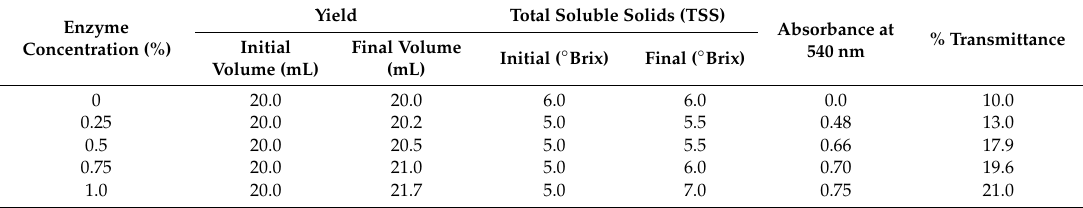
Table 1. E ff ect of di ff erent pectinase concentrations on yield, total soluble solids, and